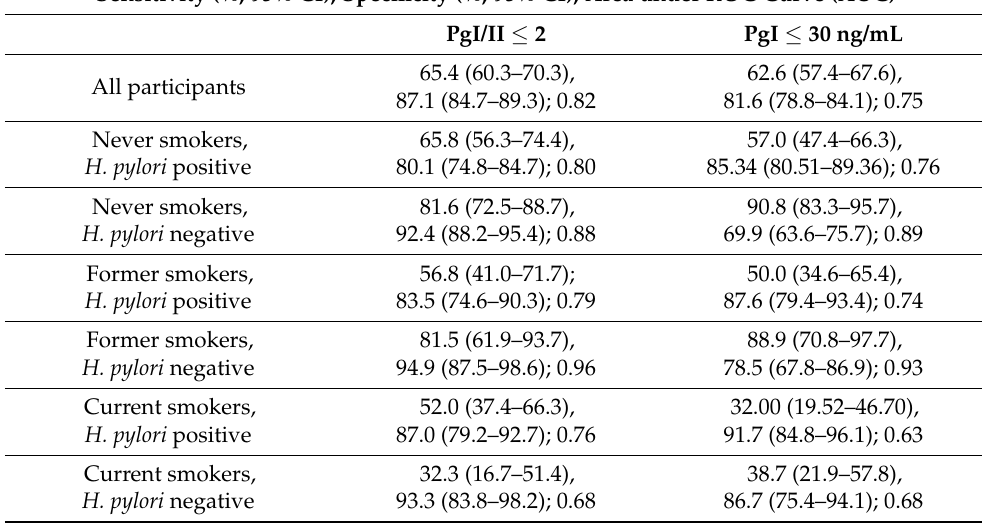
Table 4. Sensitivity and specificity for detecting precancerous gastric lesions by smoking status and H. pylori presence when using pre-existing pepsinogen cut-off